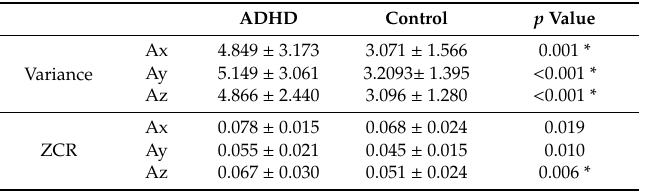
Figure 3. An example of one patient’s and one control’s variance in the accelerometer measurements in the three axes. Data indicate higher variance values of the accelerometer measurements in the x -,